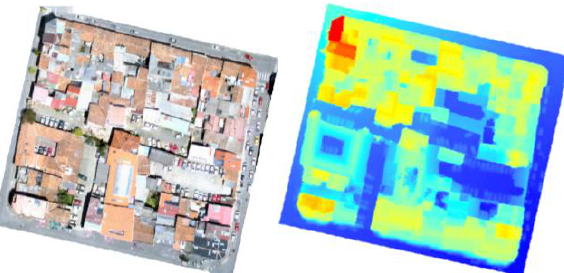
Figure 3. Detection of the parking spaces and interior buildings at the inner part of the city building blocks.